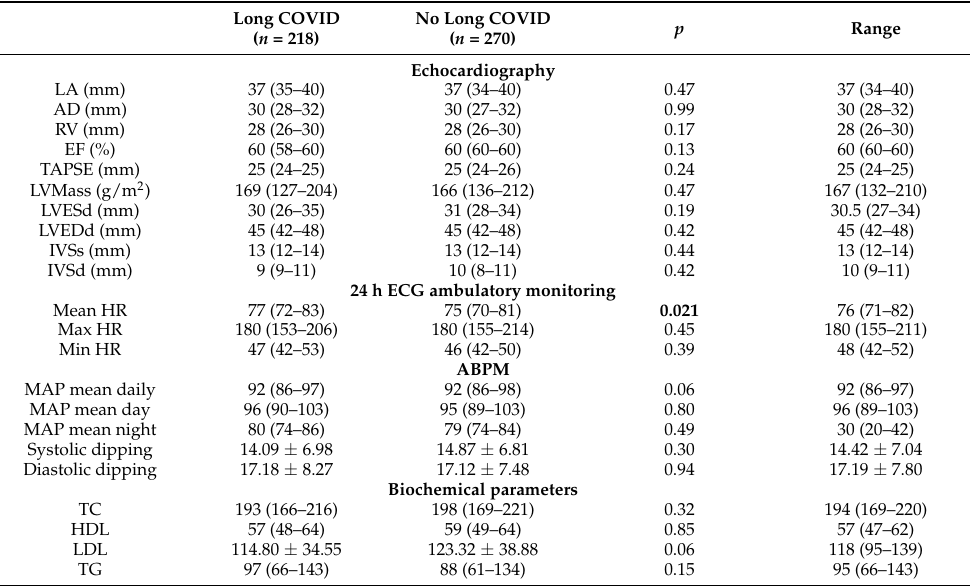
Table 4. Differences between groups with and without Long COVID among patients without